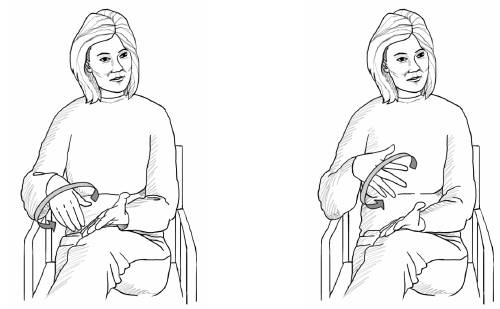
Gesture depicting mixing mud,